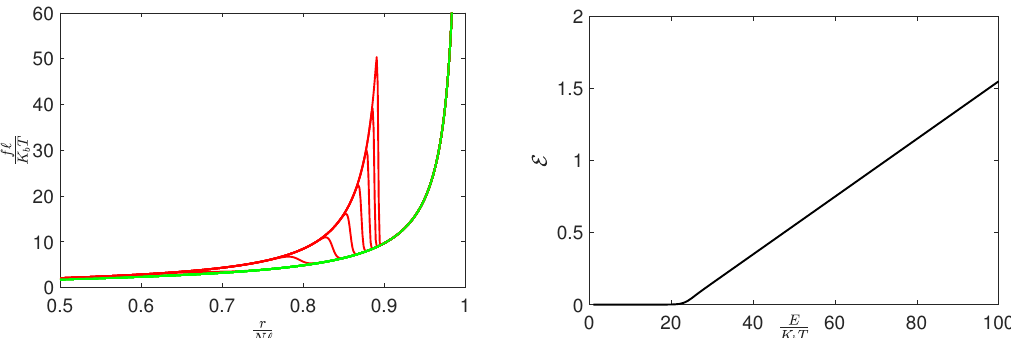
Figure 7. Helmholtz force–extension response (left panel, red curves) and extra-toughness (right panel, black curve) for a chain with s = 1 and n = 5 and an increasing value of the rupture energy E . We also added the response of the same system without sacrificial bonds in order to compare the different behaviors (green curve). On the left panel, we assumed E / ( K b T ) = 10,20,30,40,50,60,70,80,90,100, while on the right panel, we varied E k / ( K b T ) continuously be- tween 0 and 100. The plots are represented with adimensional quantities. The other parameters are given by N = 50, h / k = 1, and d / (cid:96) = 1/10.